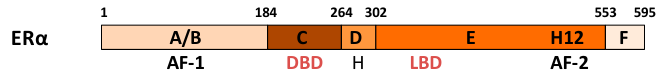
Figure 2. Nuclear/genomic effects of ER α . Nuclear/genomic and rapid extra-nuclear membrane actions (MISS) of ER α are presented in the middle panel, with loss of function mouse models (on the right ) and estrogenic compounds (on the left ) activating both nuclear and membrane ER α (E2), selective activation of either extra-nuclear actions of ER α (EDC, Estrogen-Dendrimer Conjugate